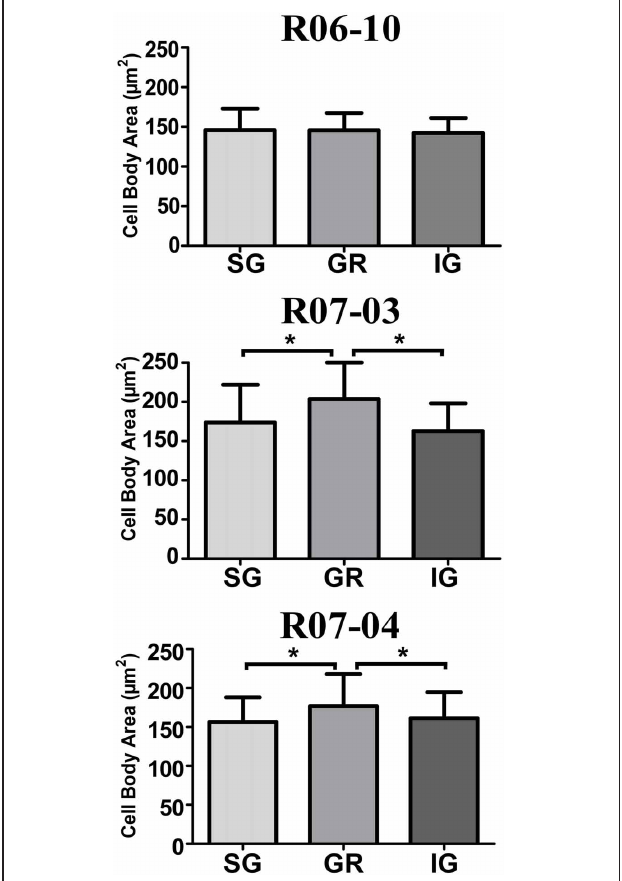
FIGURE 7 | Mean cell body area of nitrergic neurons. Layer IV (GR) neurons presented the largest cell body area in cases R07-03 and R07-04. Asterisk ( ∗ ) represents p < 0 .